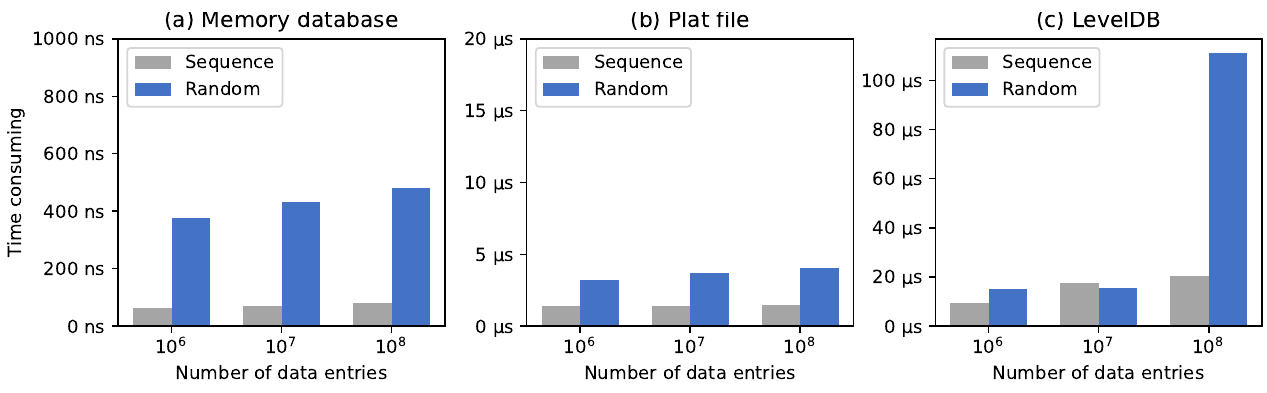
Figure 12. Comparison of the reading times of different data storage